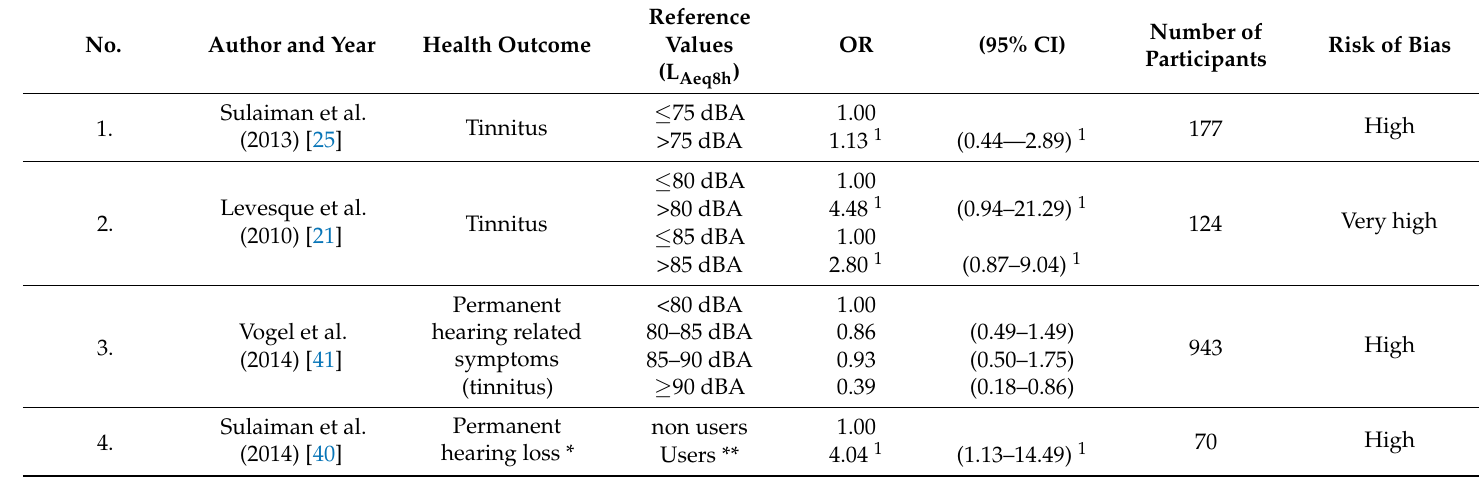
Table 5. Odds ratios (95% confidence intervals, CI) of tinnitus/permanent hearing-related symptoms depending on reference value (L Aeq8h ) and permanent hearing loss in users vs.